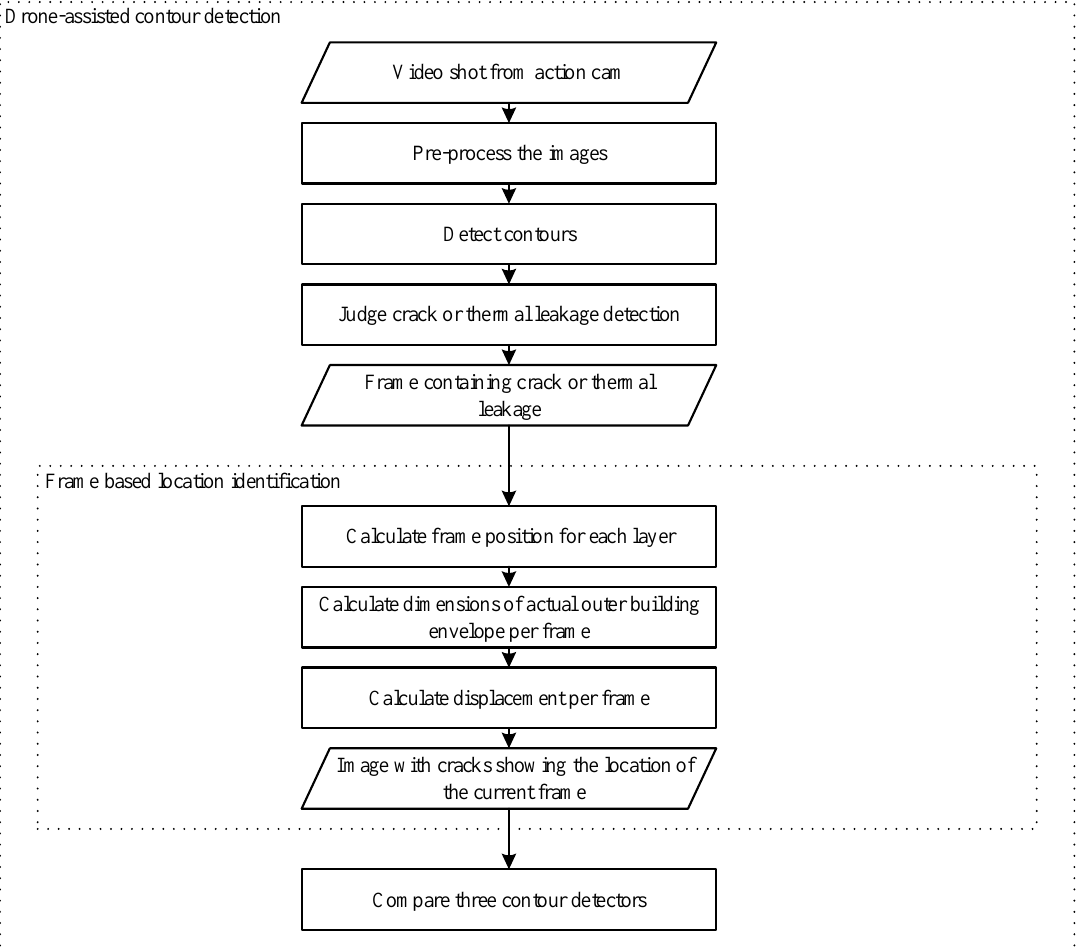
Figure 5. Flowchart for the overall anomaly contour detection.